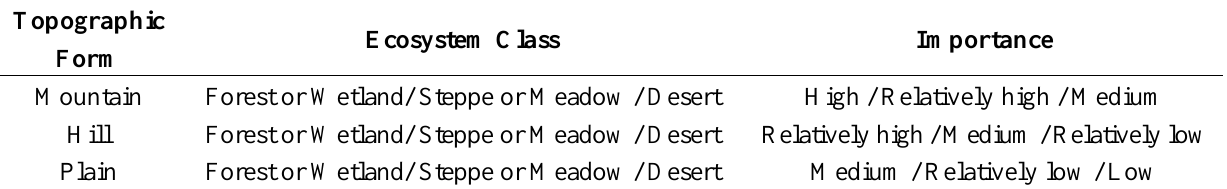
Table 2. Importance index for water conservation